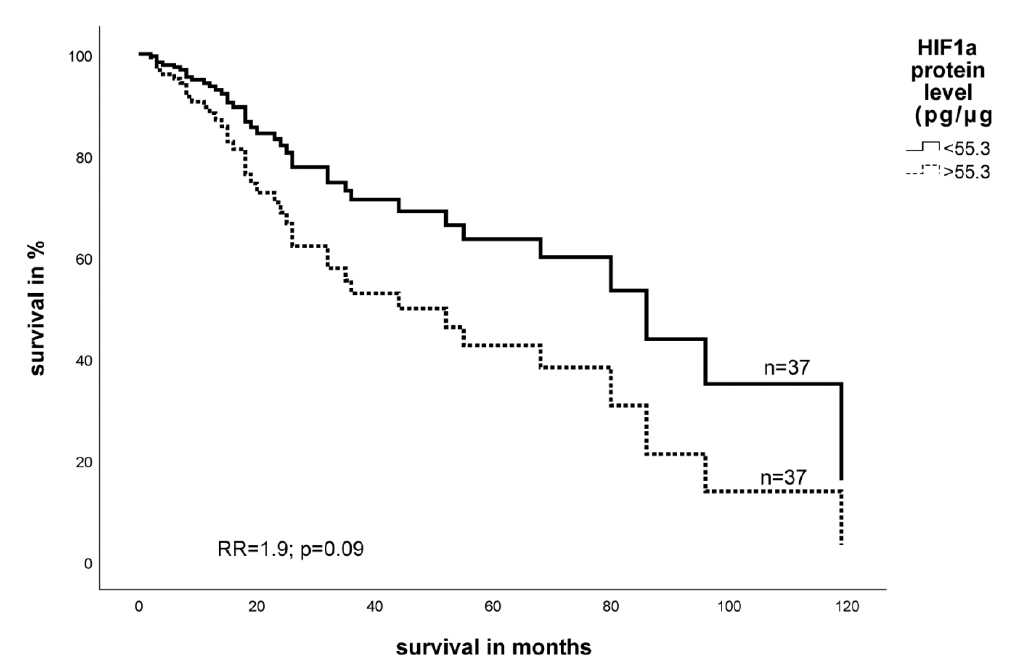
Figure 4. Multivariate Cox’s hazard regression model for HIF-1α protein expression and tumor-specific survival in STS patients. The expression of HIF-1α protein for 74 STS patients was associated with survival. The model was adjusted for tumor stage, tumor localization, tumor entity, and the type of tumor resection. The high and low cut-off values for HIF-1α were >55 and ≤55 pg HIF-1α per µg protein, respectively (RR = 1.9, p = 0.09).